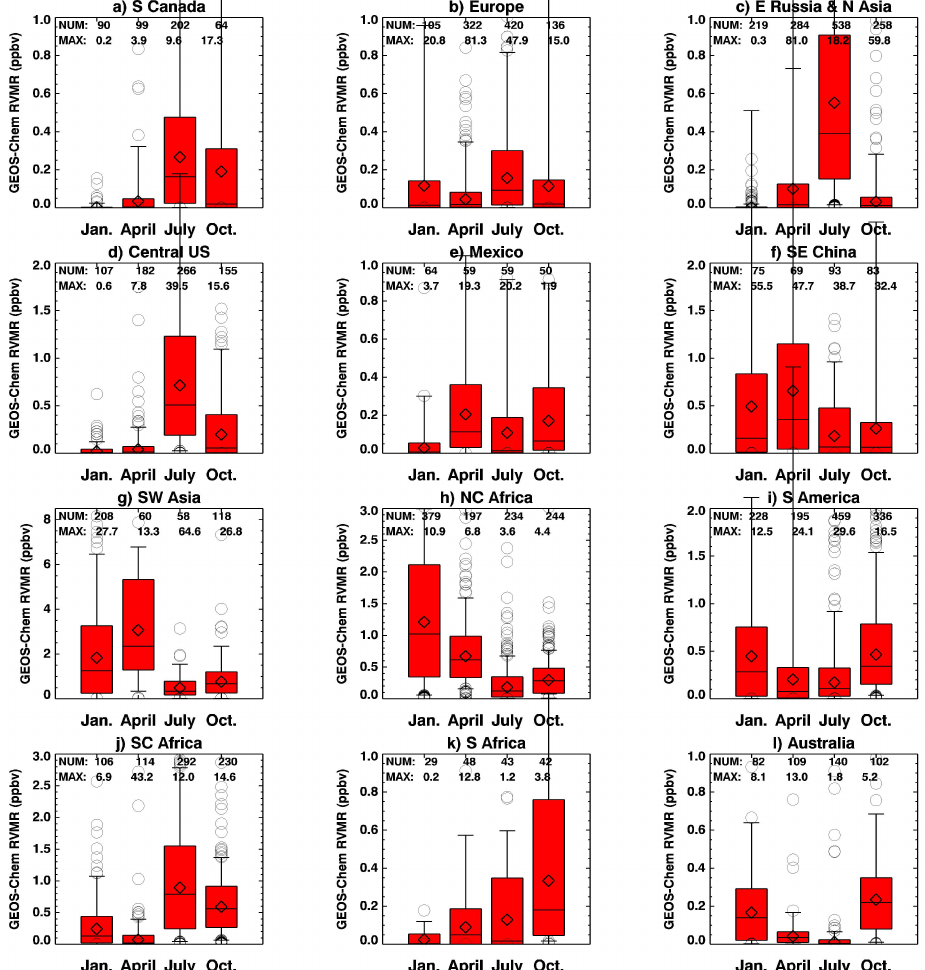
Fig. 16. GEOS-Chem NH 3 averages in Fig. 12 for each region in Fig. 14 for the 4yr period spanning 2006–2009. The boxes are the 25 and 75 percentile, the line in the box is the median, the diamond is the mean, whiskers are the 10 and 90 percentile and the circles are the outlier values outside the